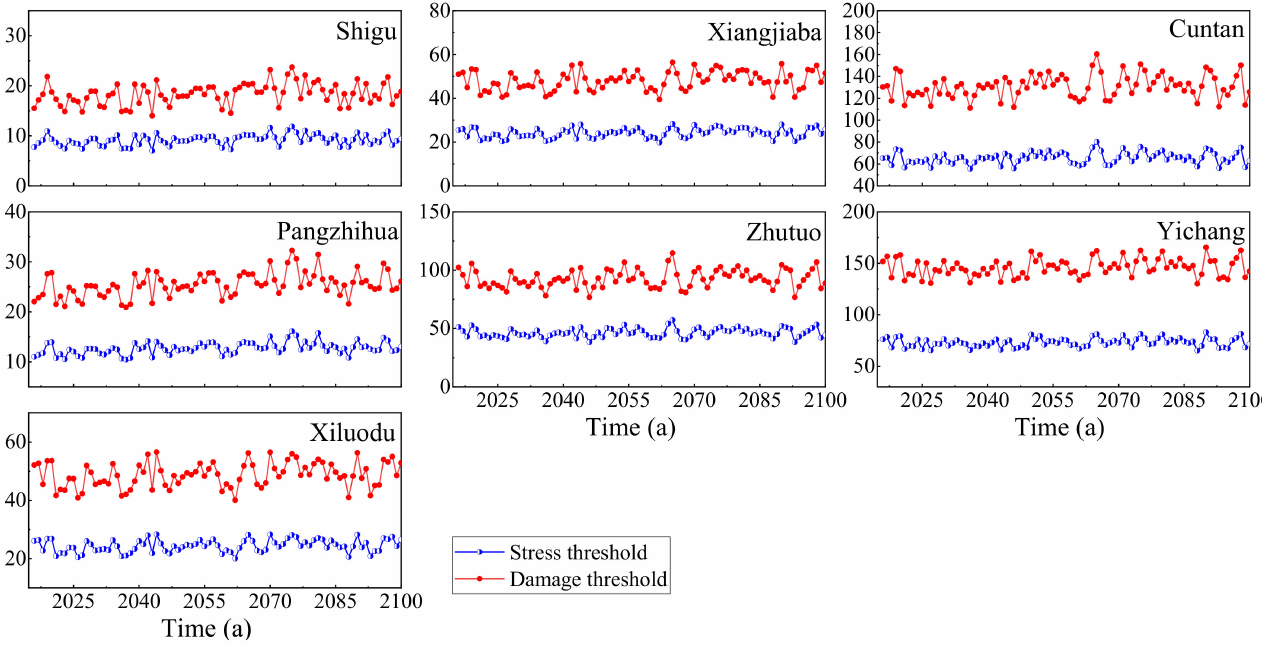
Figure 10. Utilizable threshold of surface water resources in evaluated sections of the upstream